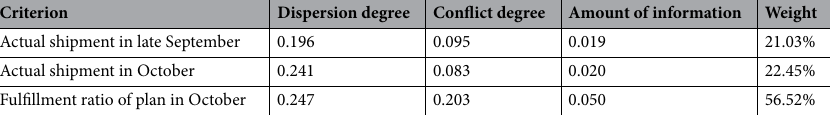
Table 3. The results of the improved CRITIC